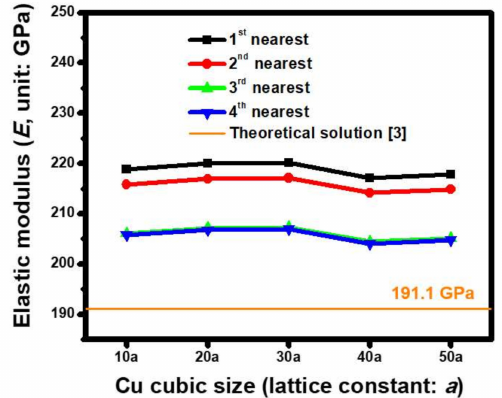
Figure 7. Size dependence of the estimated E acquired by ACM-based FEA combined with the Morse parameters of set 5 when the (111) orientation of the Cu crystal cube is introduced ( a = 3.61